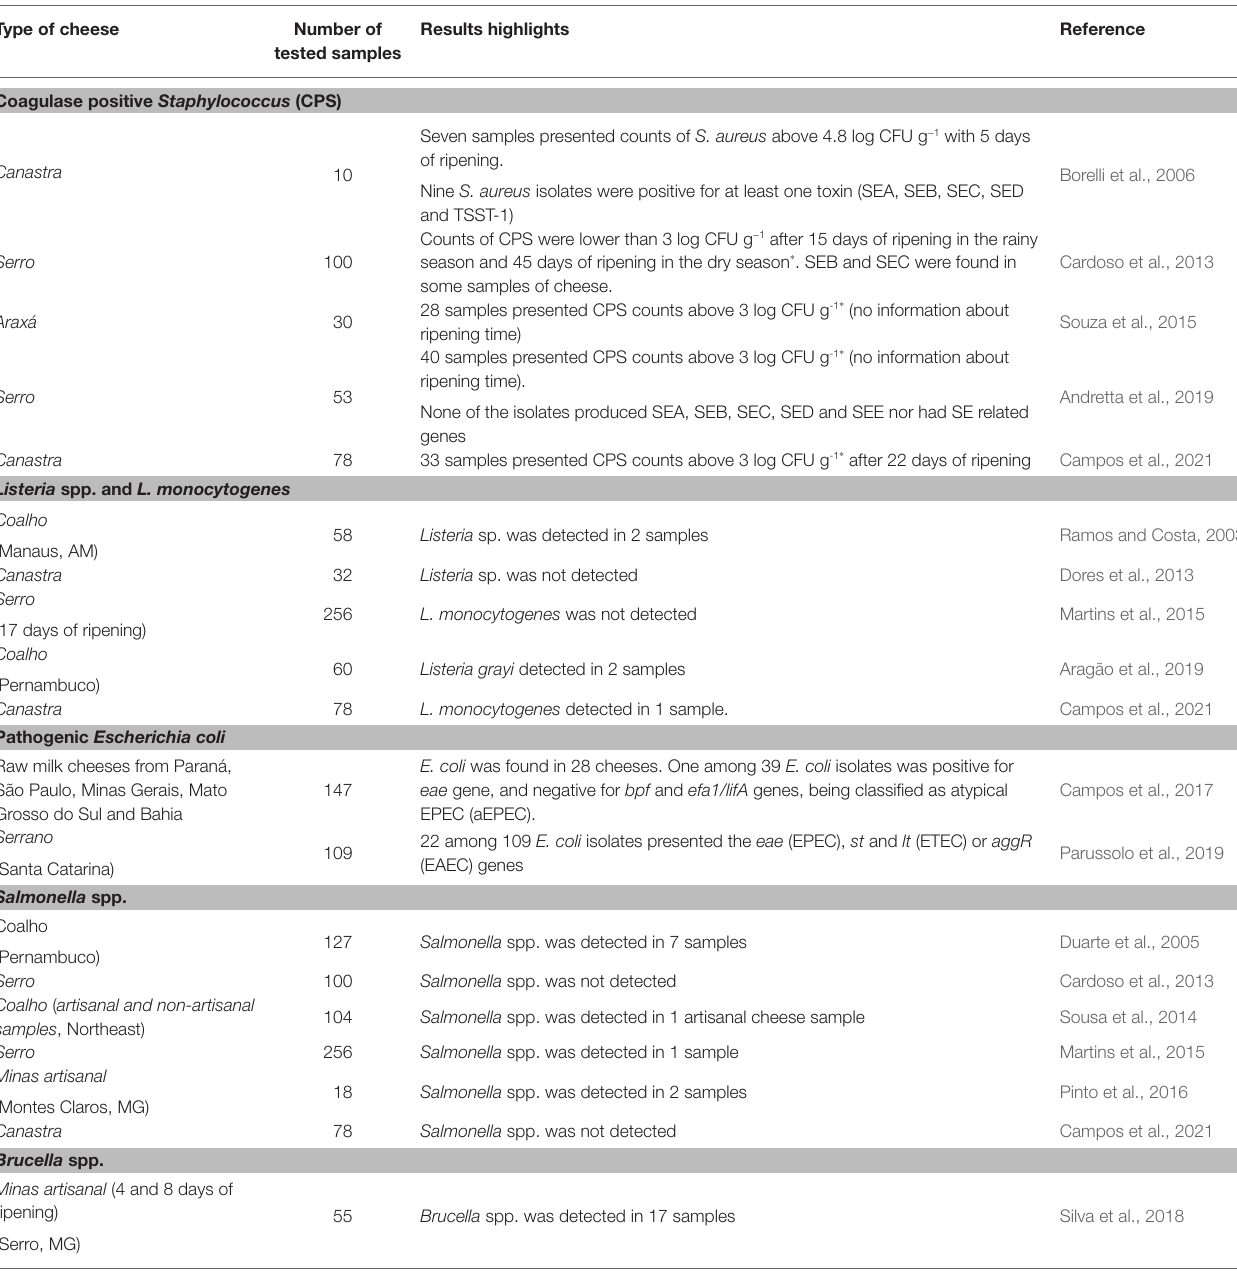
TABLE 2 | Summary of studies on pathogenic bacteria in Brazilian artisanal cheeses. Type of cheese Number of Results tested samples